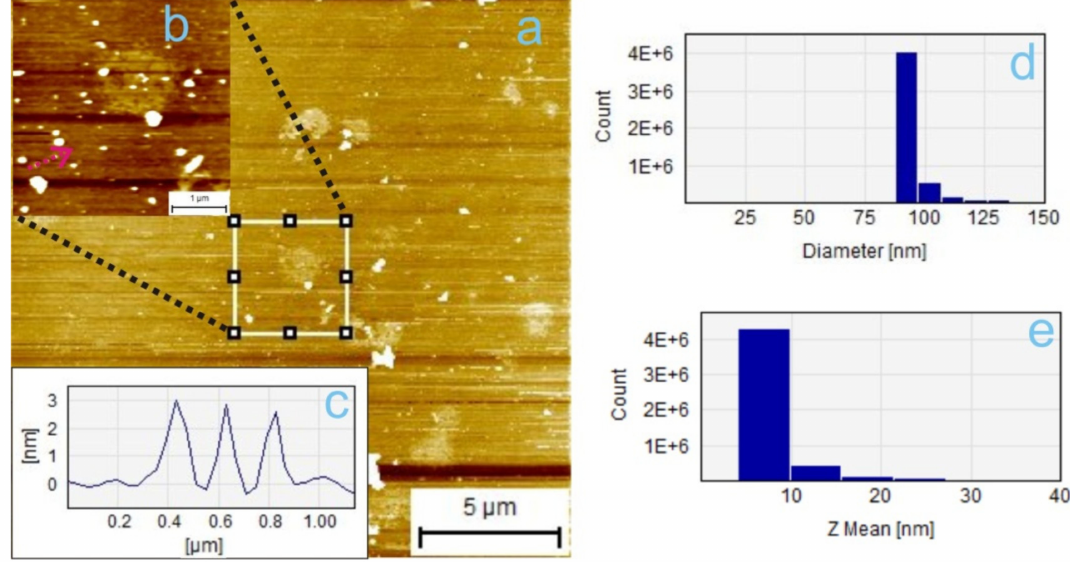
Figure 4. ( a ) AFM images of the quartz (001) surface after the zeta-potential measurements in the presence of the NPs Sample A (Figure 3, blue data points, pH 7); ( b ) magnified image of nanoparticles on surface; ( c ) height profile (along the line highlighted in b of NPs; ( d , e ) mean diameter and mean height of the